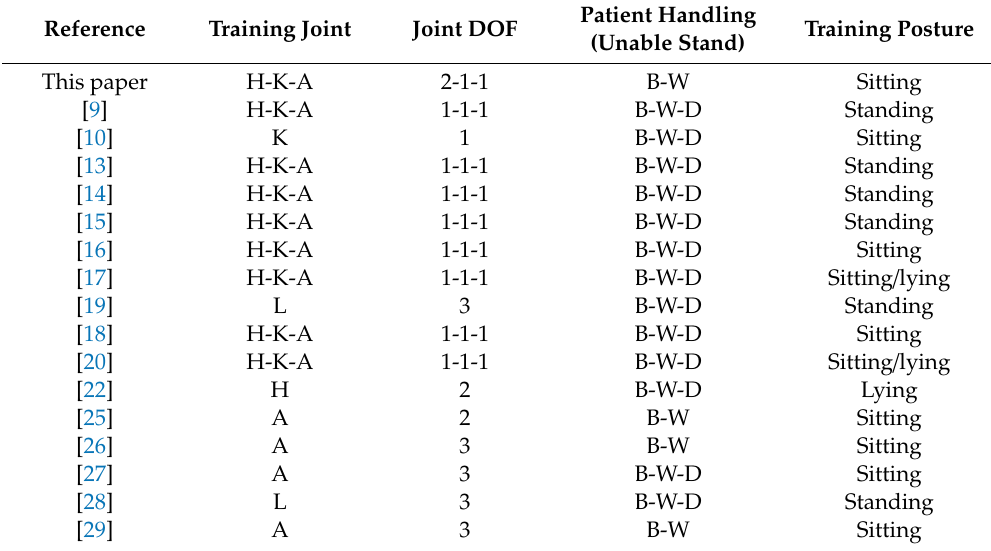
Table 1. Comparison summary of typical lower rehabilitation robots. Hip (H), Knee (K), Ankle